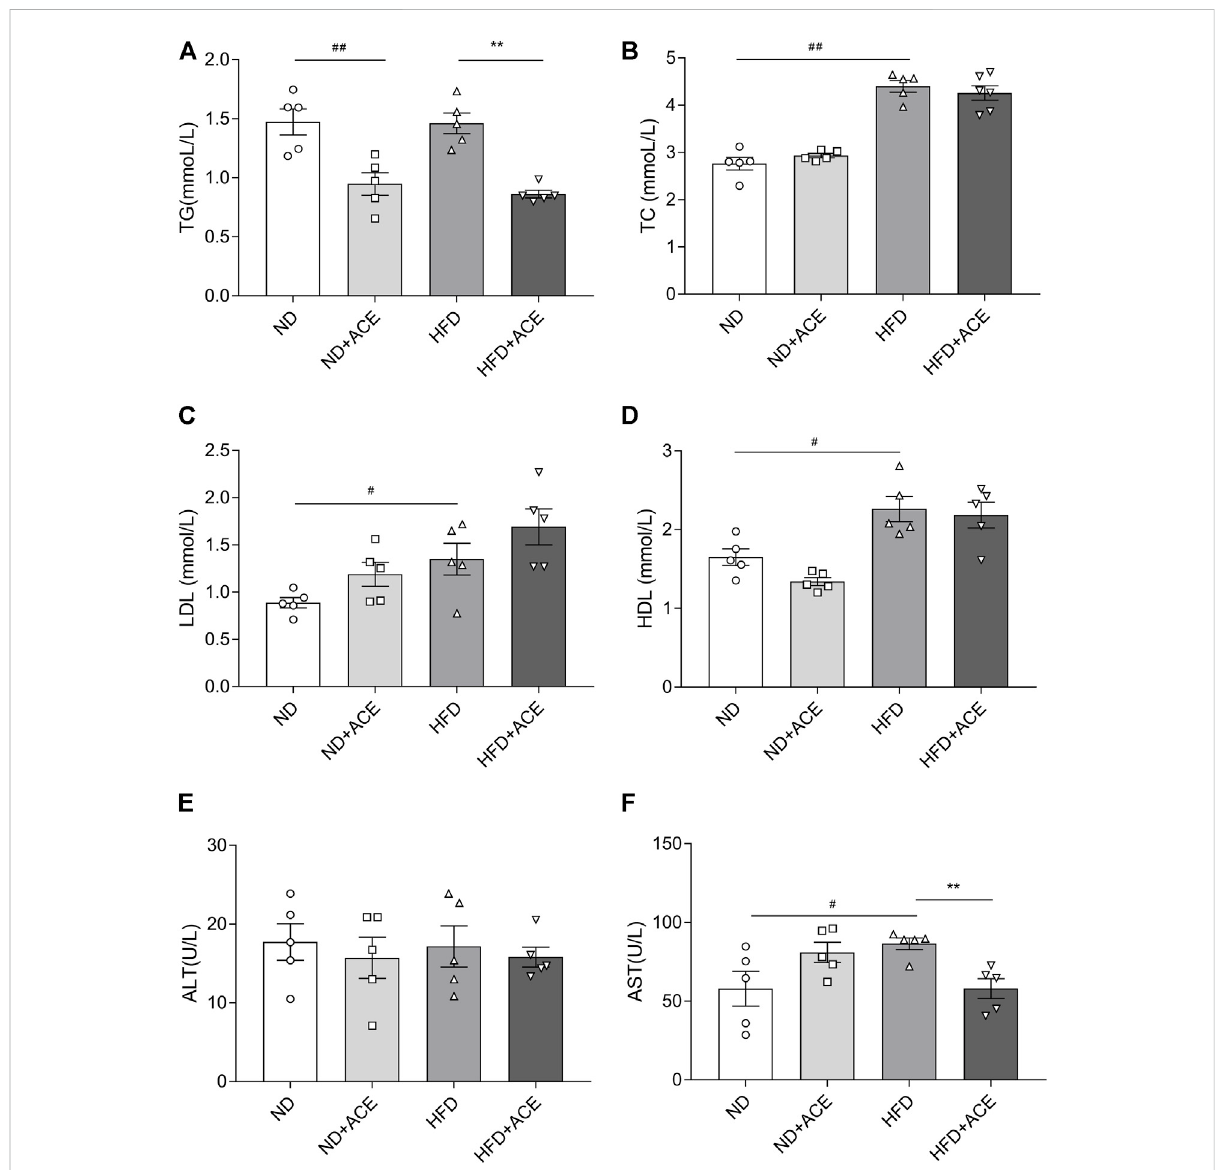
FIGURE 2 ACE ameliorated HFD-induced abnormal blood metabolic parameters. (A) TG content in plasma. (B) TC content in plasma. (C) LDL content in plasma. (D) HDL content in plasma. (E) ALT content in plasma. (F) AST content in plasma. Data were shown as means ± S.E.M (n = 5 per group). Statistical analysis was conducted by using an independent student- t test. # denotes p < 0.05 when compared with the ND group, ## denotes p < 0.01 when compared with the ND group; * denotes p < 0.05 when comparedwith the HFD group, ** denotes p < 0.01 when compared with the HFD